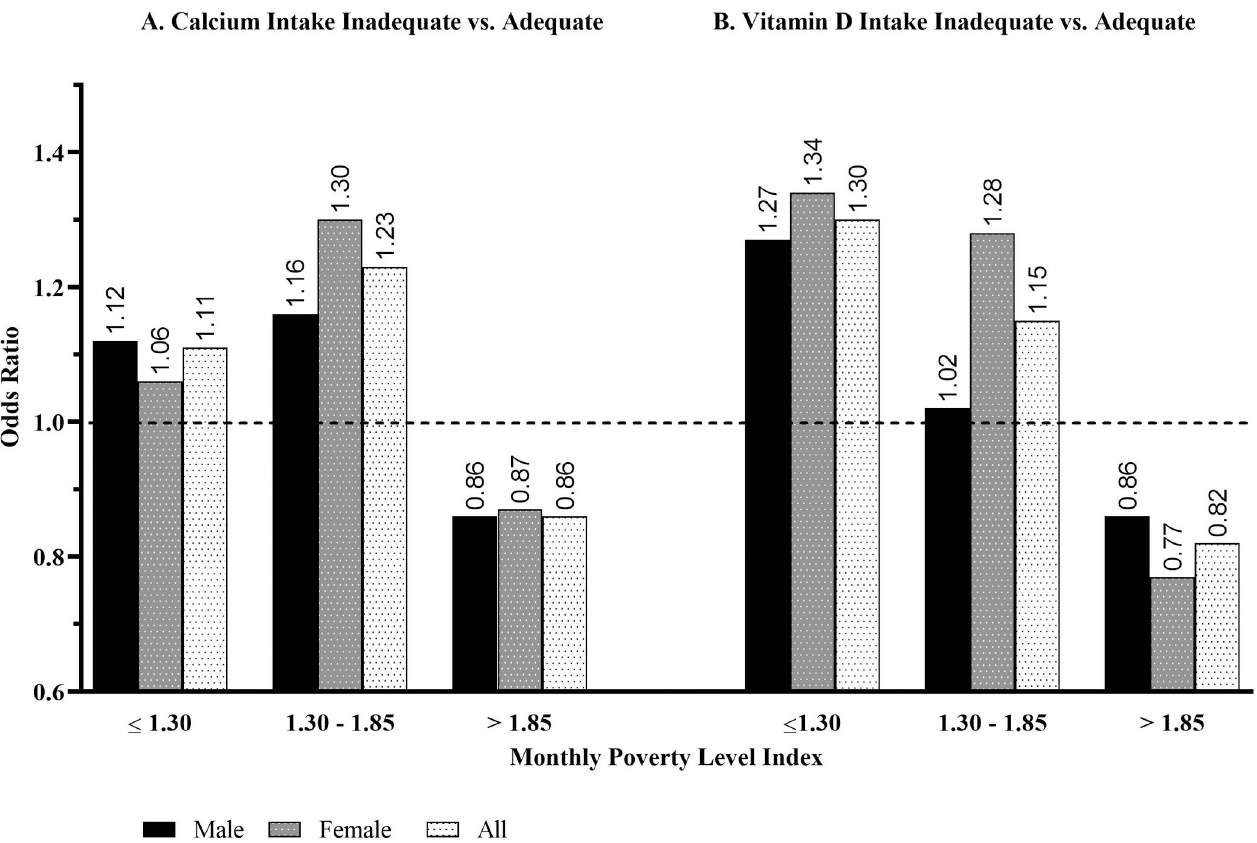
Fig 1. Odds of nutrient intake inadequacy given monthly poverty level index category levels, age 50 and older.